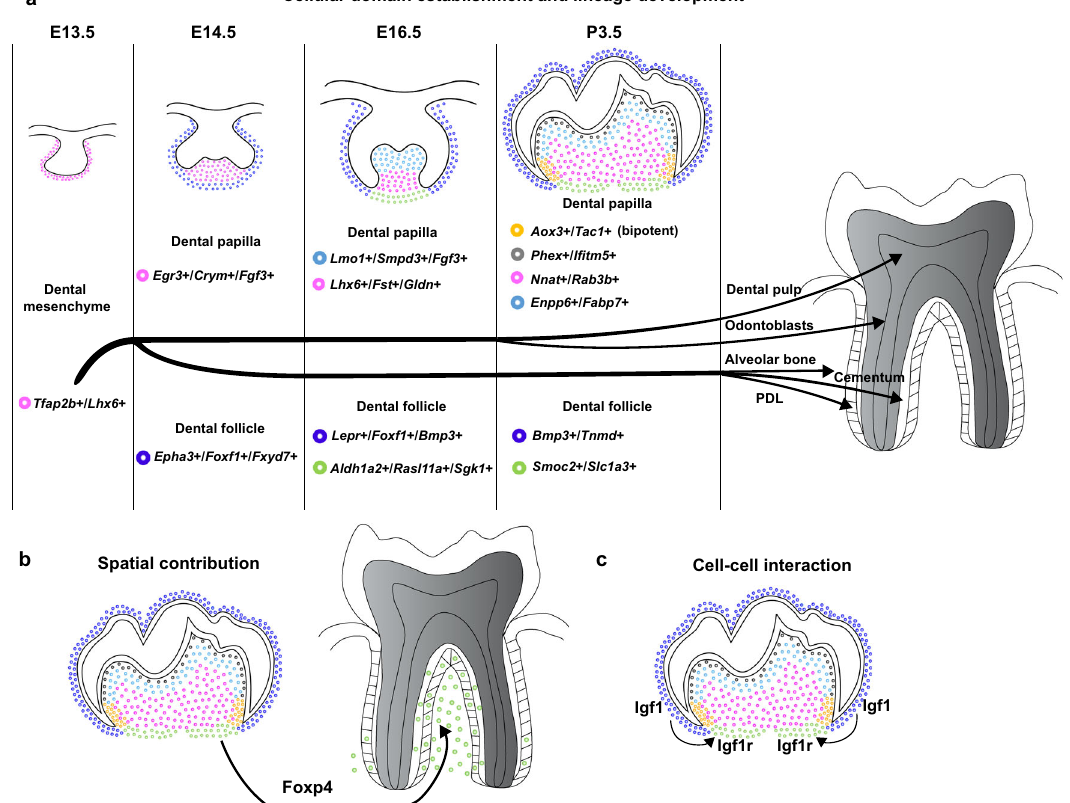
Fig. 9 | Schematic representation of cell fate decisions in the dental mesench- yme during mouse molar formation. a Landscape of cellular domain establish- ment and lineage development in the dental mesenchyme during mouse molar